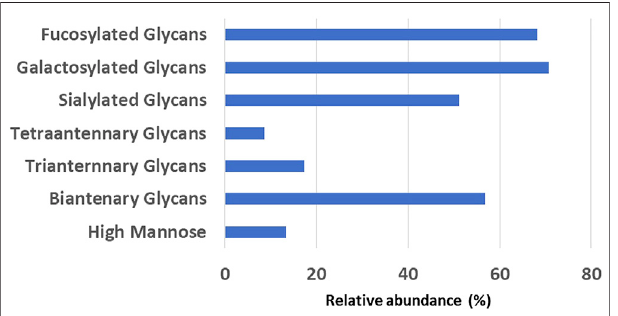
FIGURE 2 | The relative abundance levels of various glycan attributes obtained by summing the corresponding normalized abundance levels for each glycan species that possess that attribute (listed in Table 1 ).